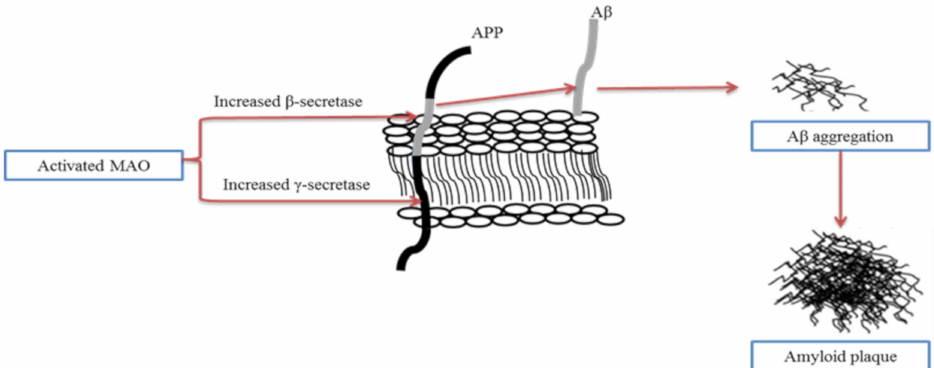
Figure 2. The mechanism of A β generation through modulation of amyloid precursor protein (APP) processing by activated monoamine oxidase (MAO). Activated MAO increases the expression of β -secretase and γ -secretase, improves A β generation, and contributes to the formation of amyloid plaques (adapted from